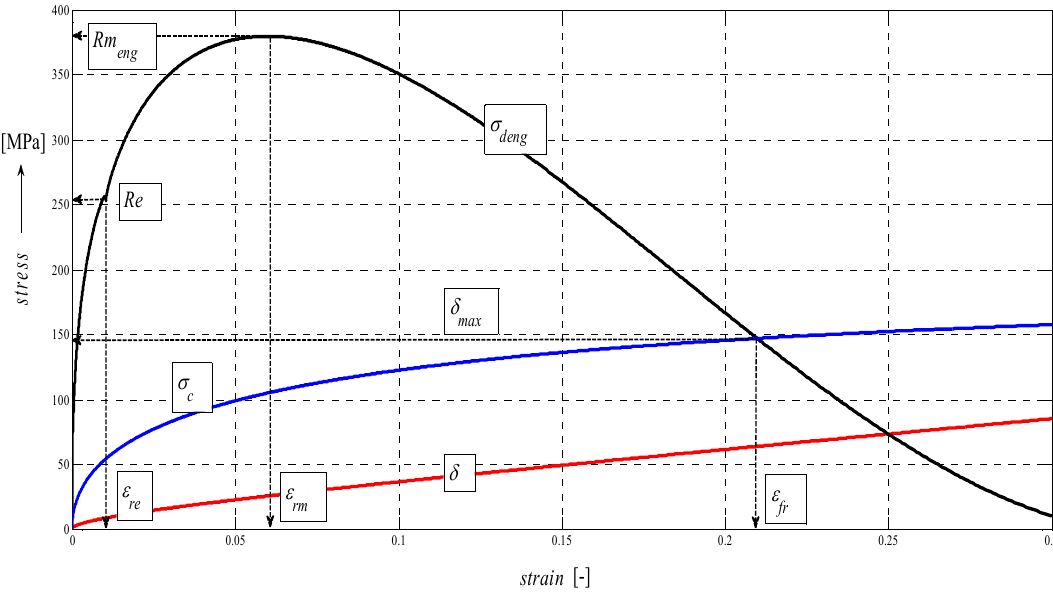
Figure 14. Diagram for AISI 1020 steel, dependence of functions on relative elongation.